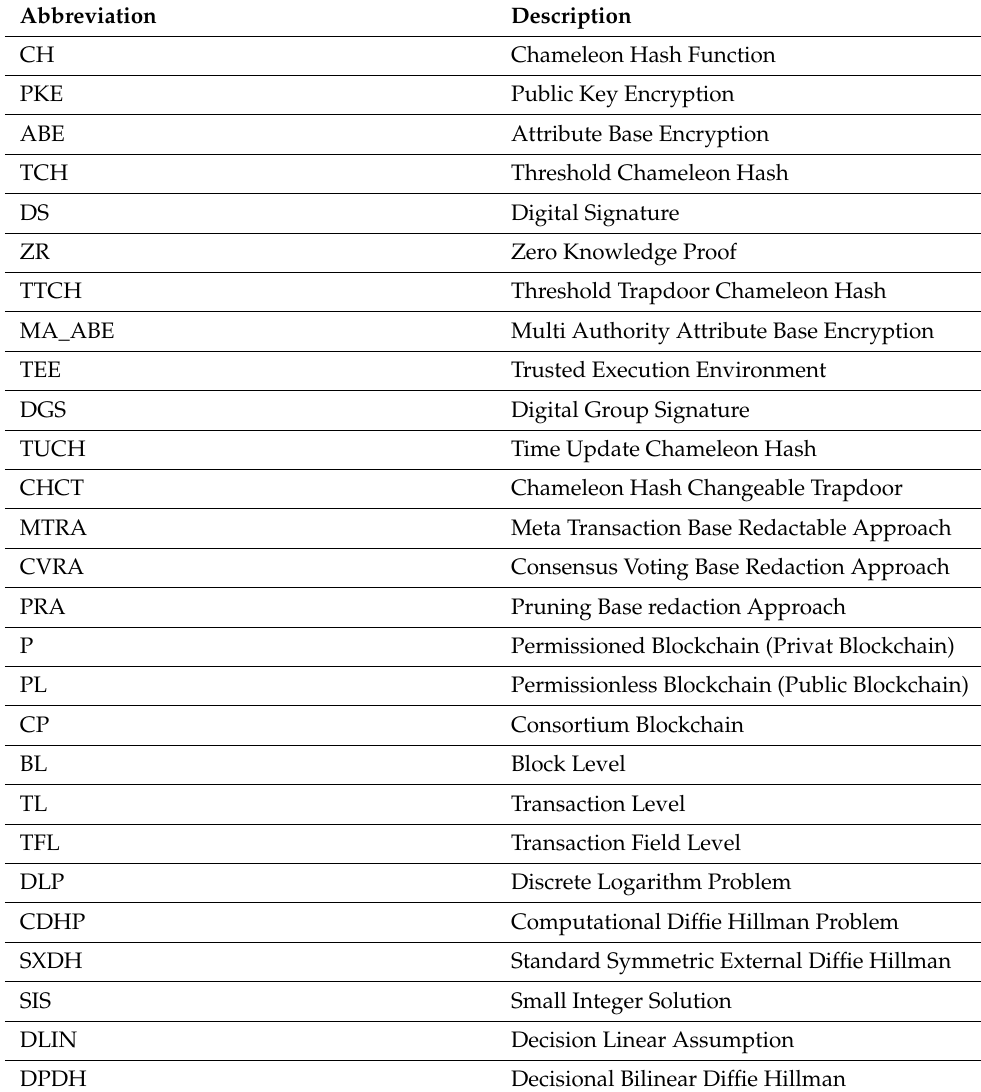
Table A1. List of